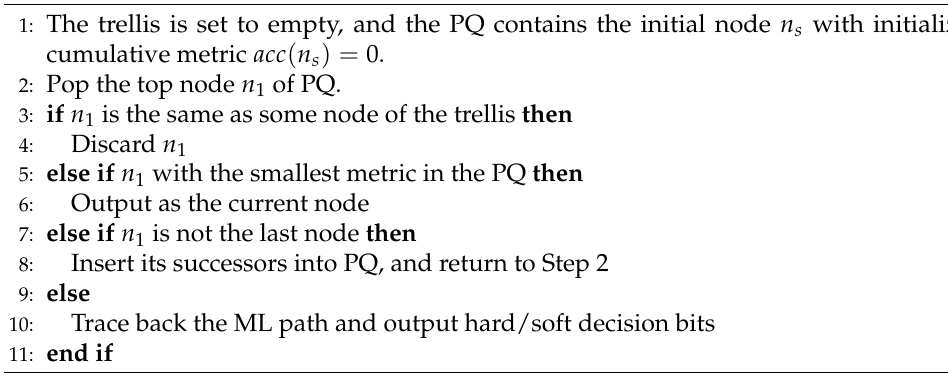
Algorithm 1 Lazy Viterbi algorithm